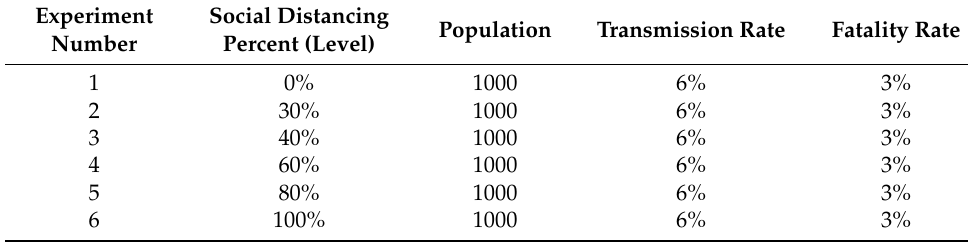
Table 2. The six experiments conditions/setting.